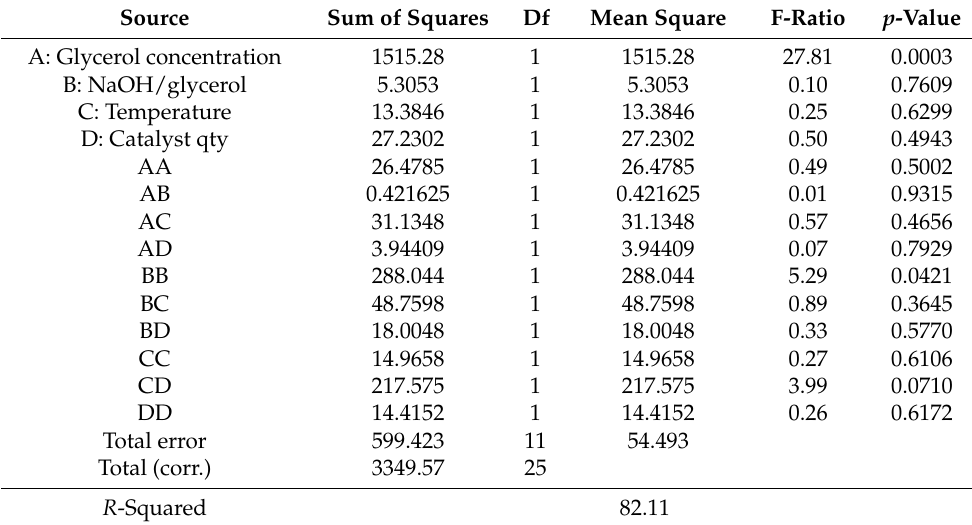
Table 5. Analysis of variance for glycolic acid (GLYA)